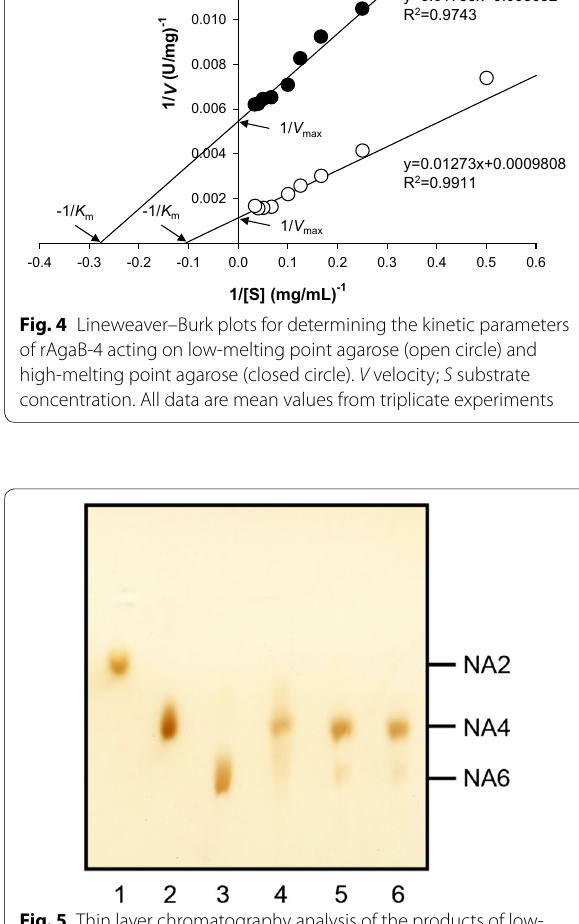
Fig. 5 Thin layer chromatography analysis of the products of low‑ melting point agarose, high‑melting point agarose, and agar hydroly‑ sis by rAgaB‑4. Lane 1 neoagarobiose (NA2); lane 2 neoagarotetraose (NA4); lane 3 neoagarohexaose (NA6); lane 4 hydrolysis products from low‑melting point agarose; lane 5 hydrolysis products from high‑ melting point agarose; lane 6 hydrolysis products from